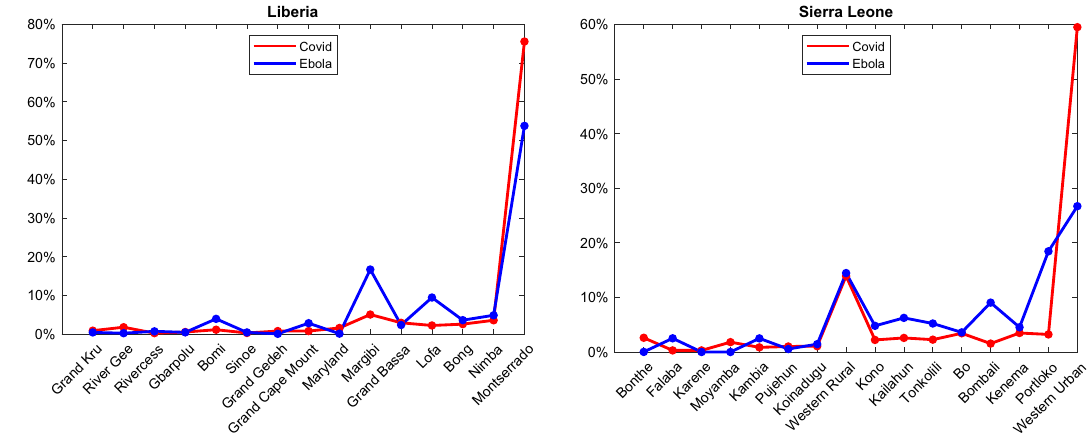
Figure 6. Observes the distribution of infected across country districts, the numbers are presented as a percentage of the total number of infected for easier comparison. The figure points to Ebola being more dispersed across districts, which is observable point by point and percentage-wise.